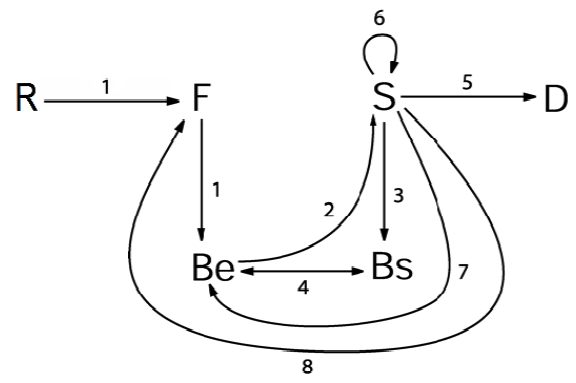
Figure 2. FBS model [17].